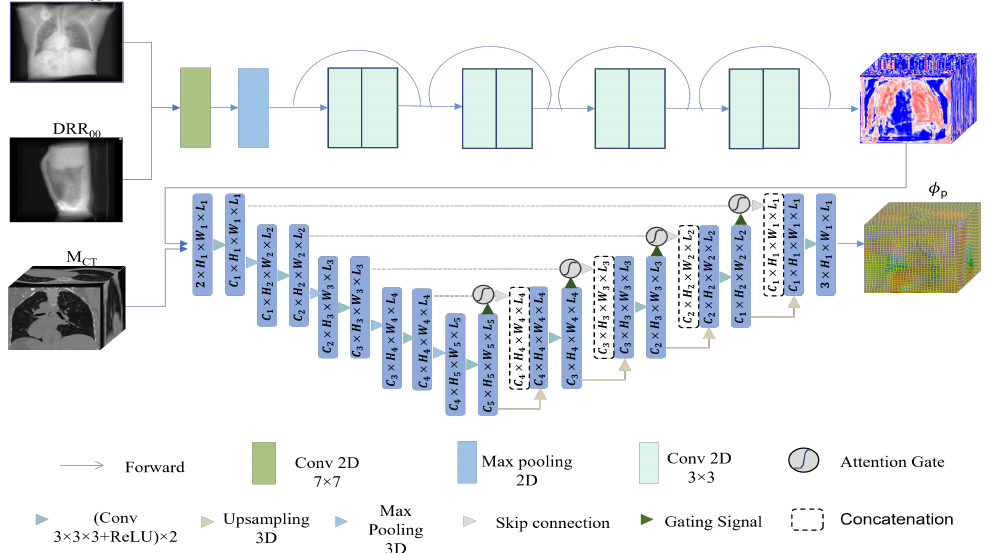
Figure 2. 2D/3D registration network. First, 2D DRRs at orthogonal angles are processed by residual blocks to obtain 3D feature maps. Then, the feature maps and moving images are fed into a 3D Attu- based encode–decode network. The final output of this network is the predicted 3D deformation